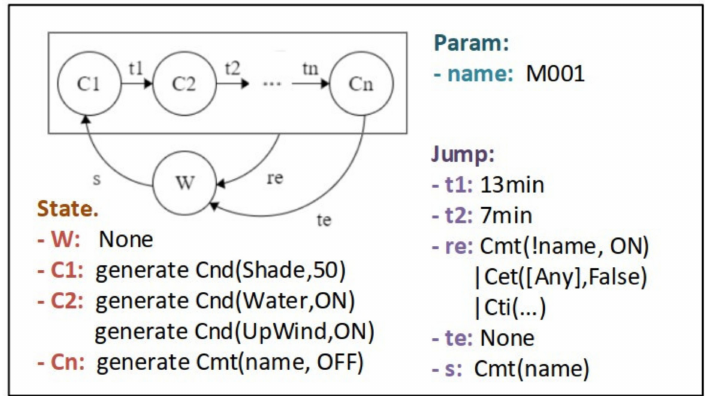
Figure 15. EPA 12.